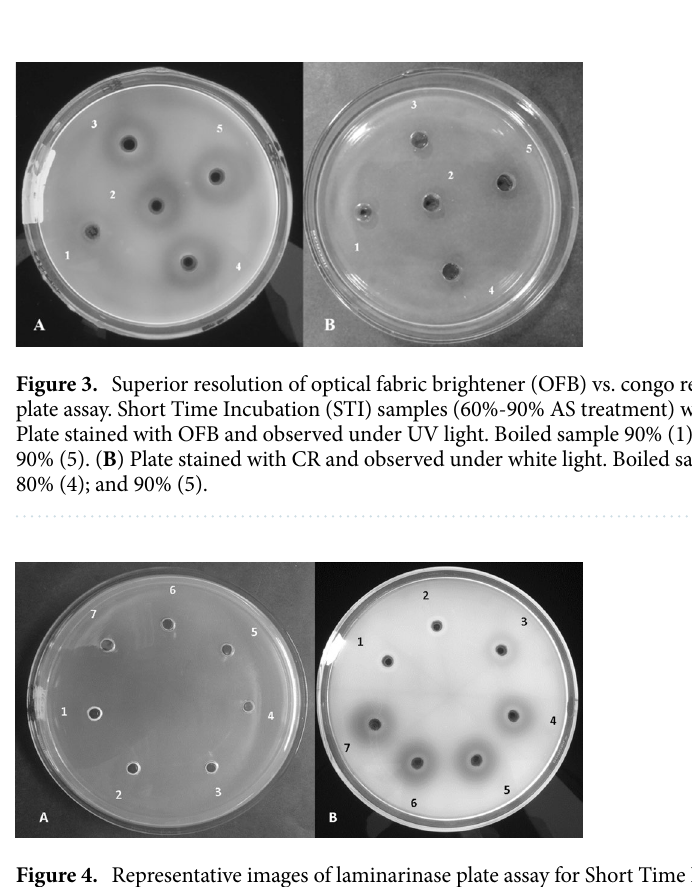
water. The plates were destained with distilled water for 20 min and observed under UV light (365 nm). Assays were carried out in triplicates. CR staining of the laminarin plate was performed with a 0.1% solution of CR for 15 min, destained twice for 15 min with 1 M NaCl and observed under white light 43 . The zones of hydrolysis were measured using a scale ruler. Pictures of the laminarin and CMC plates (white light and UV) were captured. Heat denatured samples prepared by boiling the AS protein precipitate solution at 100 °C for 20 min was used as control.